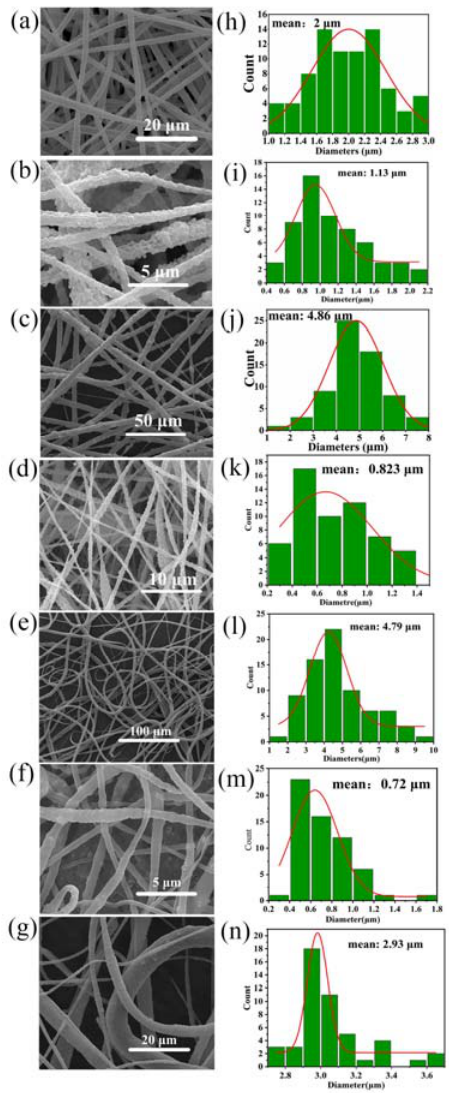
Figure 3. Fiber morphology by SEM: ( a ) pure PVDF fibers, ( b ) ZnO-PVDF, ( c ) PCL/ZnO-PVDF, ( d ) BaTiO 3 -PVDF, ( e ) PCL/BaTiO 3 -PVDF, ( f ) SrTiO 3 -PVDF, and ( g ) PCL/SrTiO 3 -PVDF. The distribution of electrospun fibers in ( h ) pure PVDF fibers, ( i ) ZnO-PVDF, ( j ) PCL/ZnO-PVDF, ( k ) BaTiO 3 - PVDF, ( l ) PCL/BaTiO 3 -PVDF, ( m ) SrTiO 3 -PVDF, and ( n ) PCL/SrTiO 3